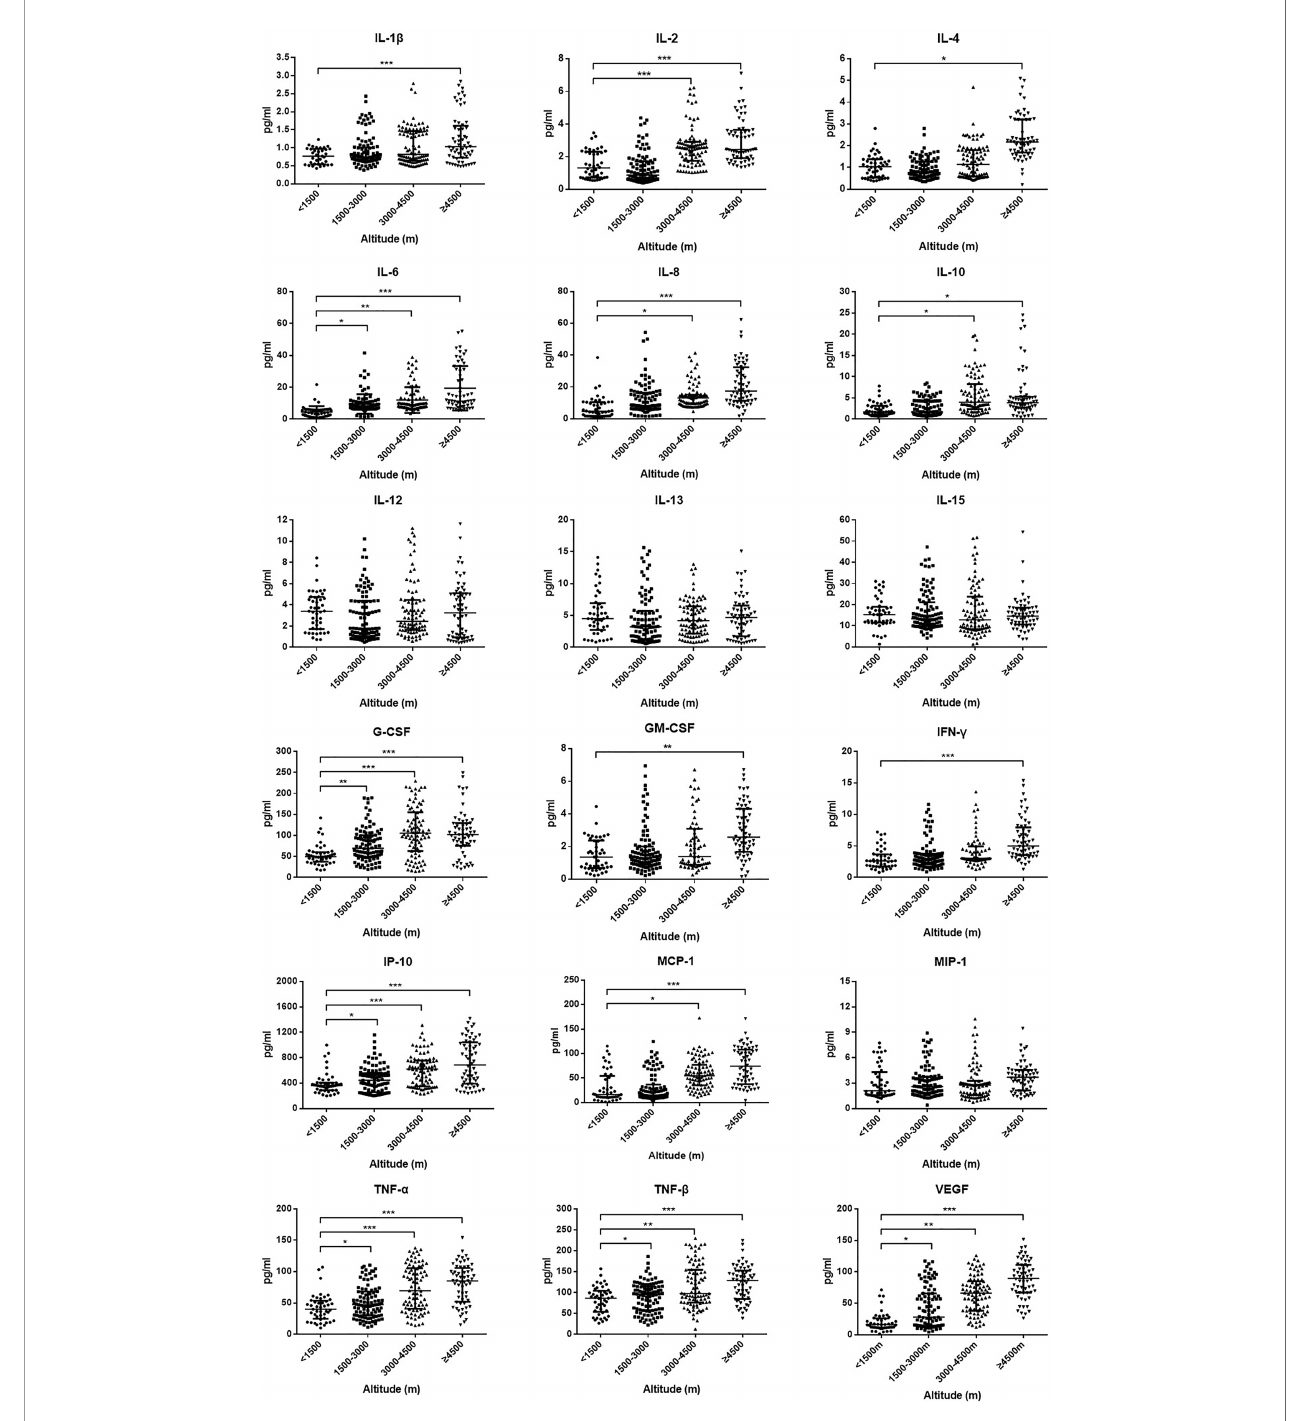
FIGURE 3 | Plasma level of cytokines and chemokines among HAdV infectious patients at different altitudes. Comparison of cytokine and chemokine levels among HAdV infectious patients at different altitudes. The vertical axes differ for each of the mediators to accommodate the extreme variation in the normal distributed range of cytokine concentrations. Data represent median and interquartile range. The Kruskal – Wallis test (followed by post-hoc analysis with Dunnett ’ s t -test with Bonferroni adjustment) is applied to compare the differences between the low-altitude group (<1,500 m) and the other groups. IL, interleukin; G-CSF, granulocyte colony-stimulating factor; GM-CSF, granulocyte – macrophage colony-stimulating factor; IFN- g , interferon g ; IP-10, induced protein 10; MCP-1, monocyte chemoattractant protein 1; MIP-1, macrophage in fl ammatory protein 1; TNF- a , tumor necrosis factor a ; TNF- b , tumor necrosis factor b ; VEGF, vascular endothelial growth factor. * P < 0.05, ** P < 0.01, *** P <